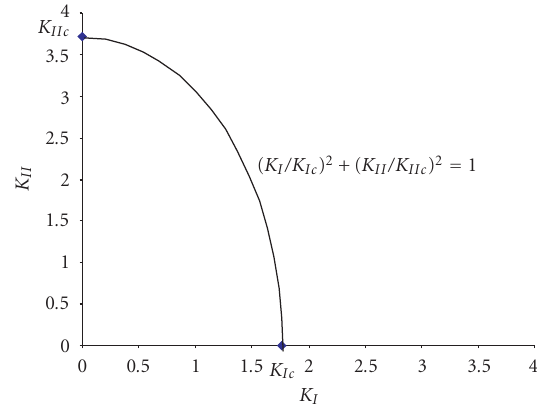
Figure 5.2. Combined mode fracture at c = 0 . 5736.